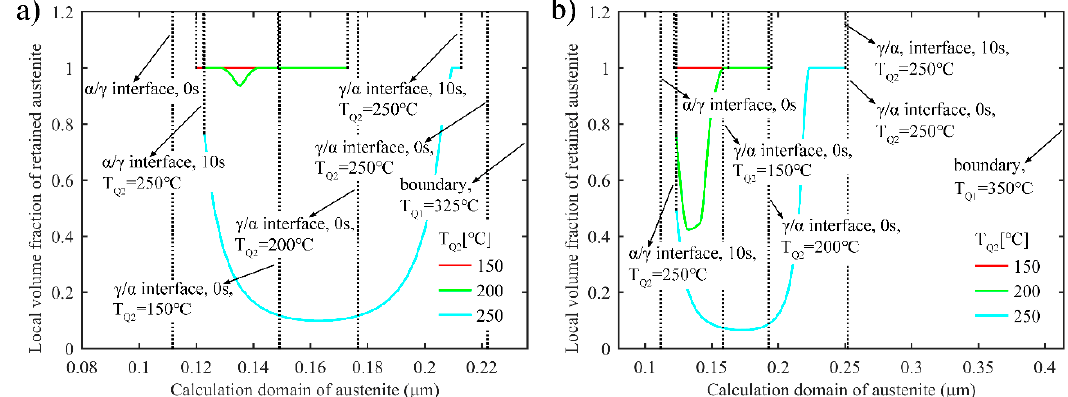
Figure 8. Local volume fraction of retained austenite after the final quenching in the two-stage Q-P process. ( a ) T Q1 = 325 ° C, T P1 = 425 ° C, first partitioning time is 10 s, T P2 = 350 ° C, second partitioning time is 10 s; ( b ) T Q1 = 350 ° C, T P1 = 425 ° C, second partitioning time is 10 s, T P2 = 350 ° C, second